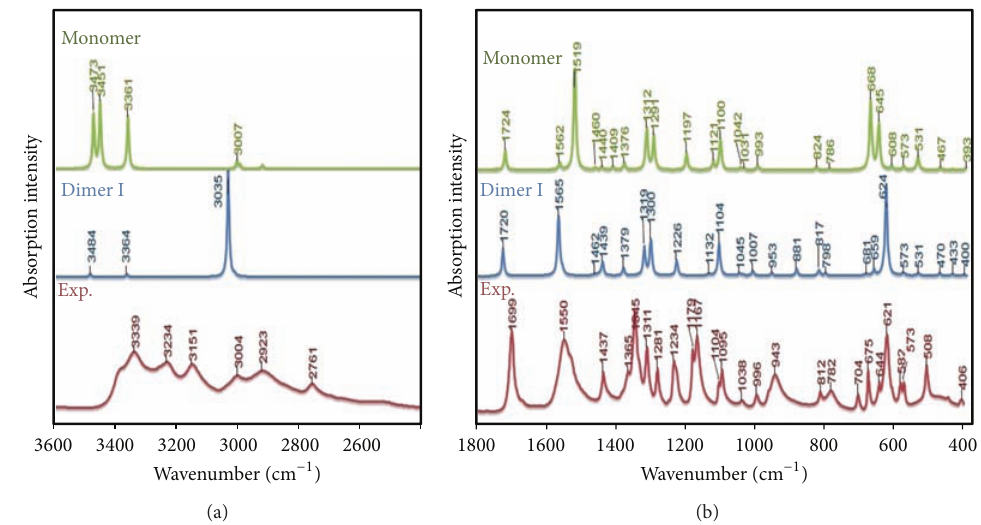
Figure 5: Experimental FT-IR (solid) and calculated (scaled) absorption intensity spectra of acetazolamide in the regions 3600–2600 cm −1 (a) and 1800–400 cm −1 (b),